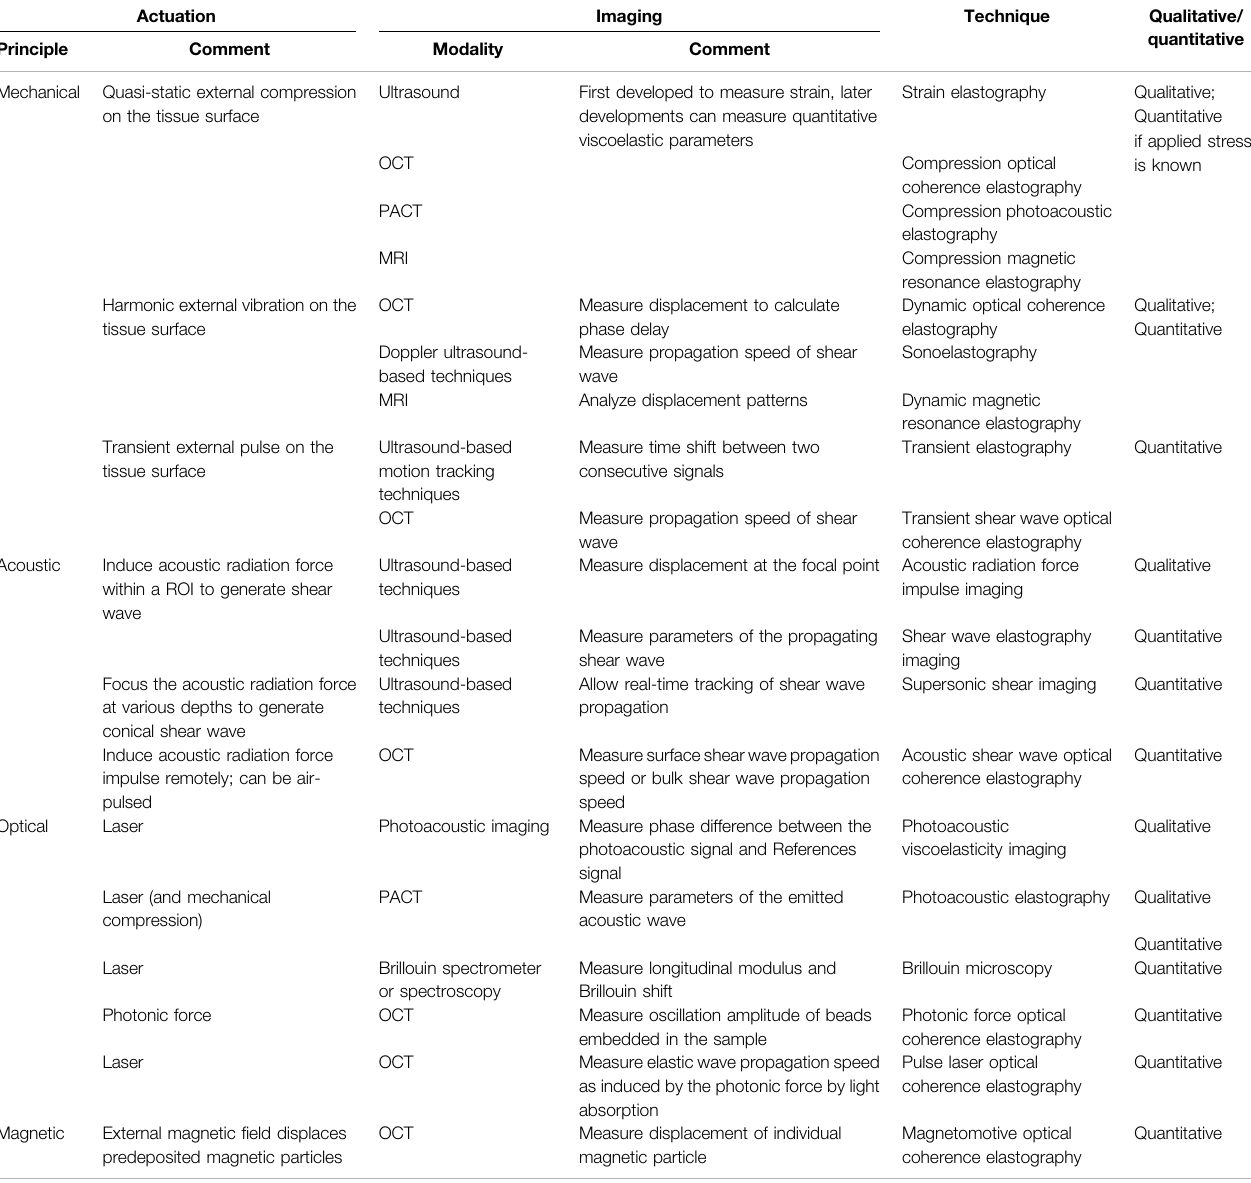
TABLE 4 | Summary of elastography